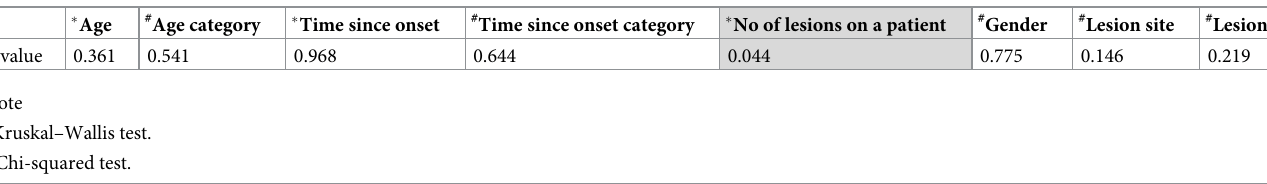
Table 3. Results of association tests for predictor factors and the treatment response to IL-SSG.